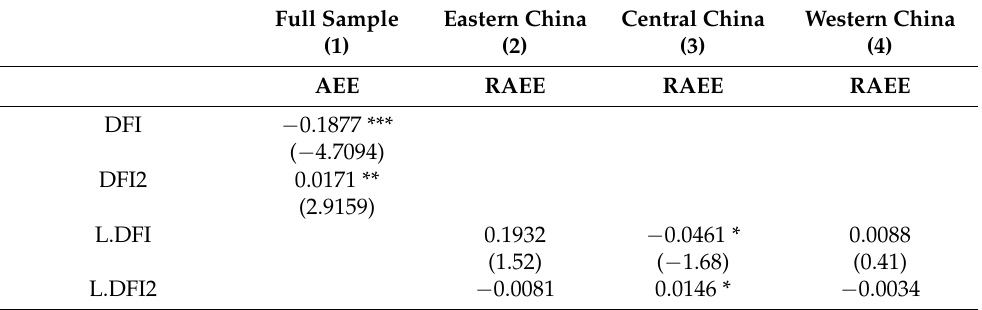
Table 4. Benchmark model regression results of the full sample and